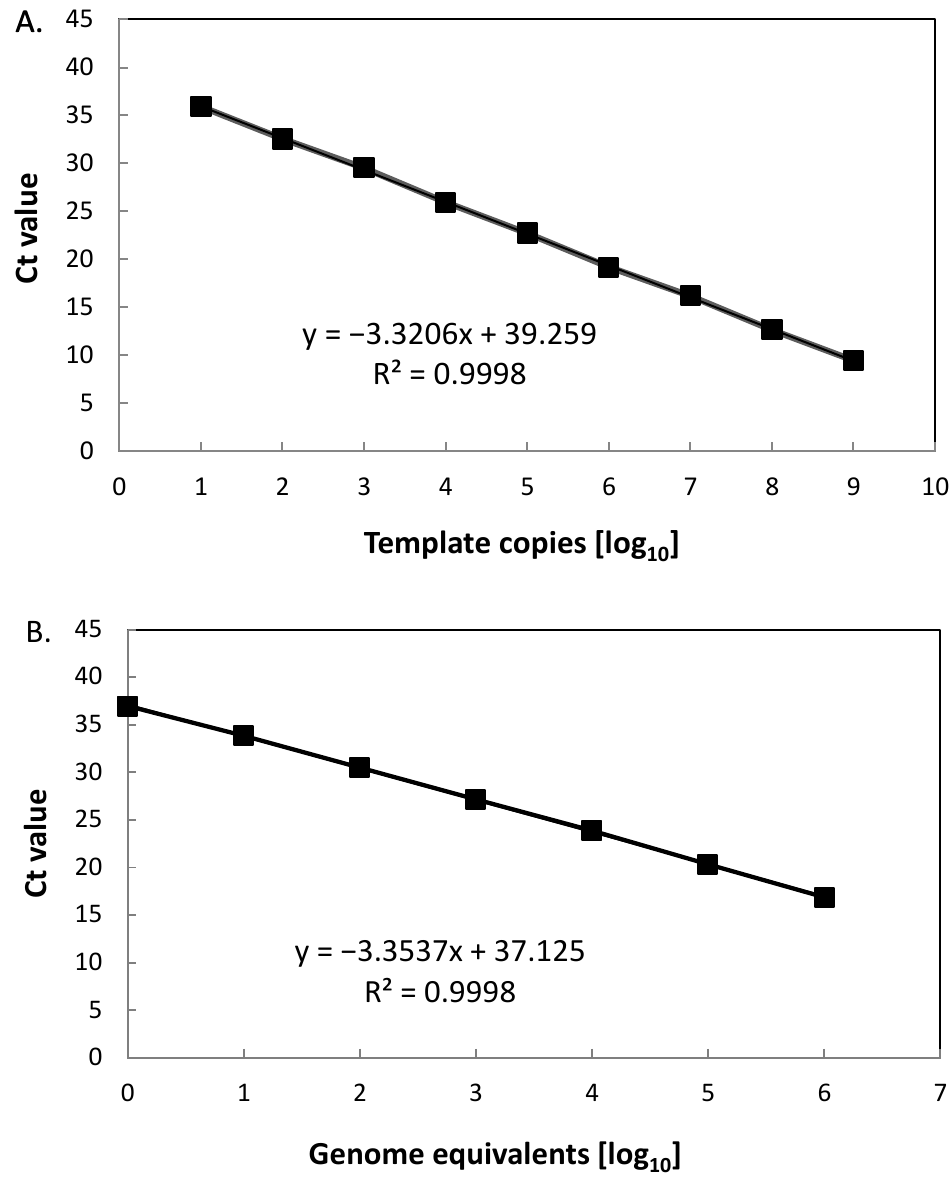
Figure 1. Linearity of the 16S rRNA SNP-PCR. Serial dilutions of DNA of ( A ) a fragment comprising the 16S-BA-allele or ( B ) B. anthracis strain Ames were serially diluted 1:10, PCR-tested, and template copies ( A ) or genome equivalents ( B ) plotted against Ct values. Indicated in the graphs are the slopes of the linear regressions and the coefficients of determination (R 2 ). Individual data points represent average values from n = 3 × 3